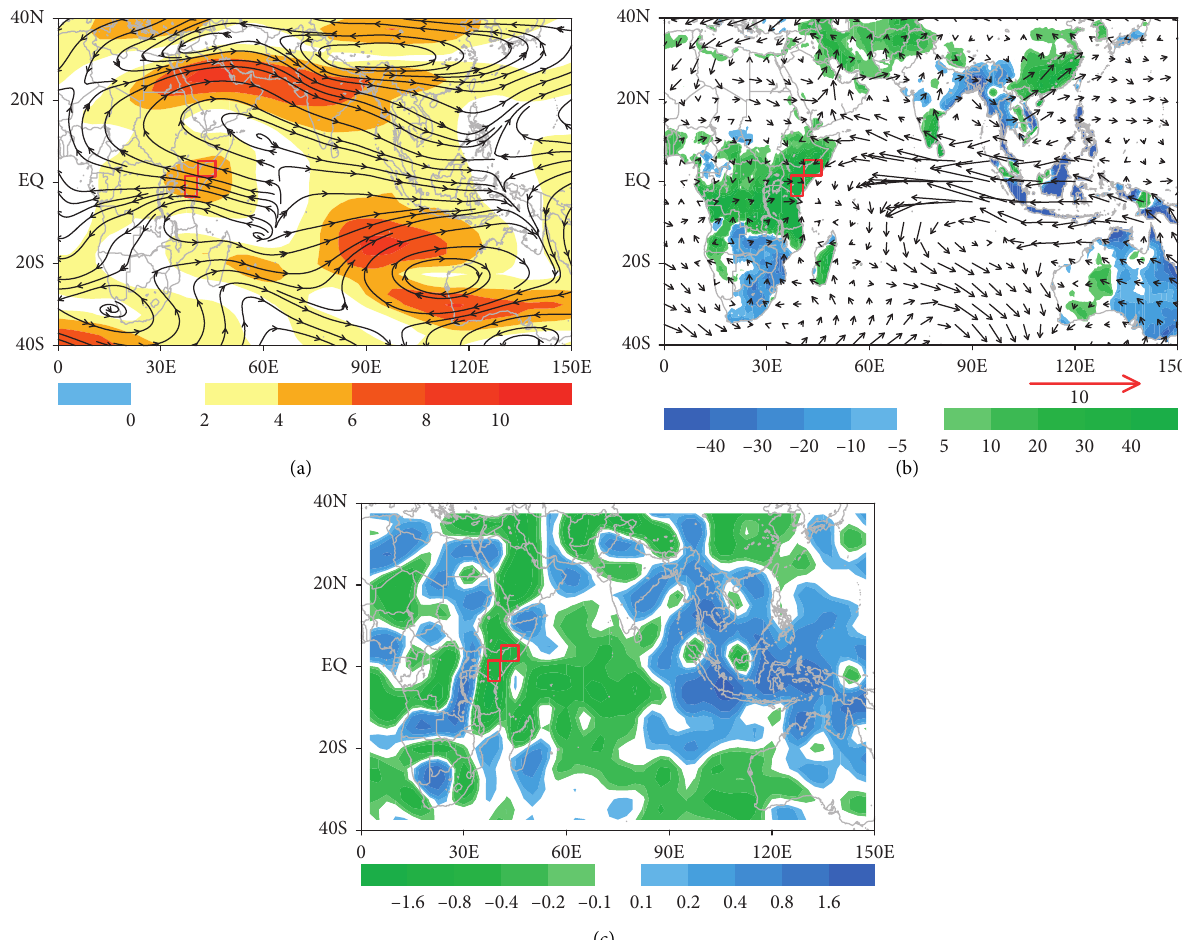
Figure 12: The difference of (a) 200-hPa wind (streamline), (b) 850-hPa wind (vector in m s − 1 ) and rainfall (shaded in mm month − 1 ), and (c) 850-hPa divergence (shaded in 10e6 s − 1 ) in OND between positive IOD years and negative IOD years. The magnitudes of wind are shaded in (a). The red boxes marked in each panel represent the OND